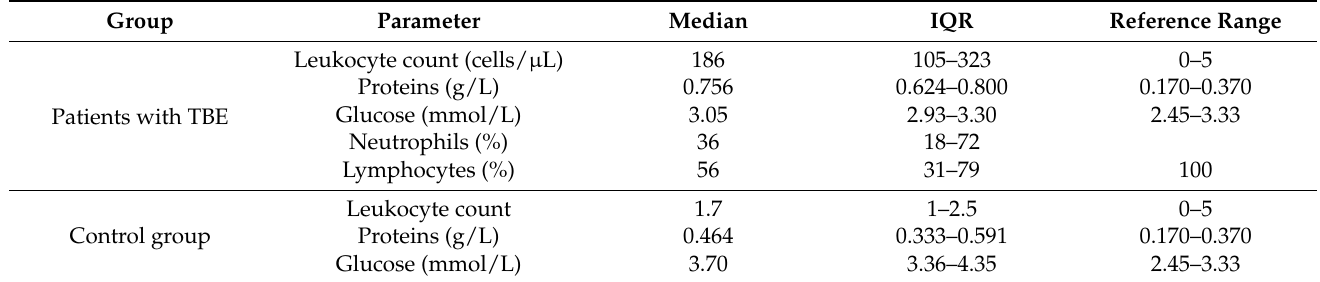
Table 2. Laboratory findings in CSF of patients with TBE and control